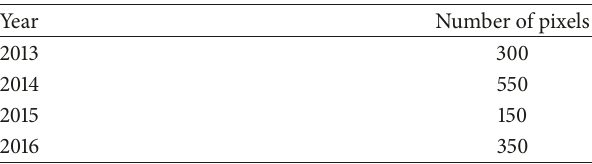
Table 2: The year and number of pixels selected throughout the growing